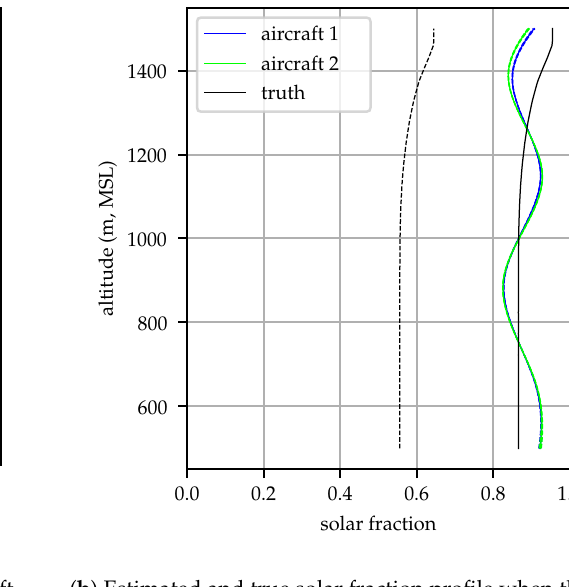
( a ) Estimated and true wind profiles when the aircraft ( b ) Estimated and true solar fraction profile when the have traveled 40 km. aircraft have traveled 40 km. Figure 8. Estimated and true atmospheric profiles and 1 σ bounds at 40 km into the flight for a simulation beginning at 16:00 UTC on 2018-12-03. Error bounds on the true profiles indicate the HRRR skill–the best that the atmospheric state can be known a priori